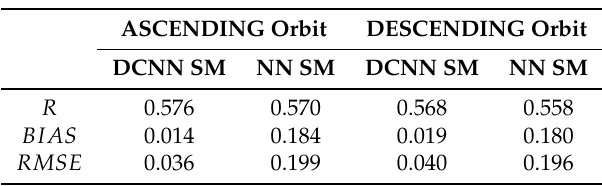
Table 3. Temporal correlation between DCNN/NN SM and ERA-Interim SM in testing phase. Data from ascending and descending orbits are processed separately.